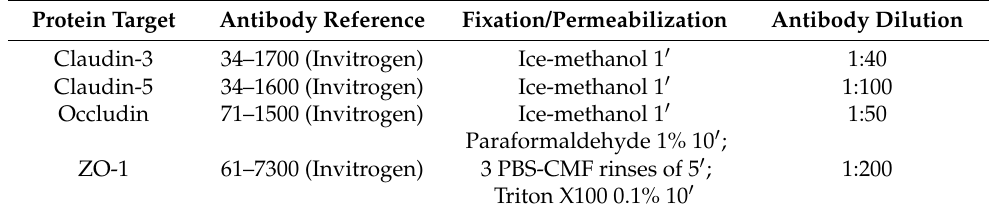
Table 1. Antibodies used for the immunostaining experiment. ZO-1: zonula occludens-1. Protein